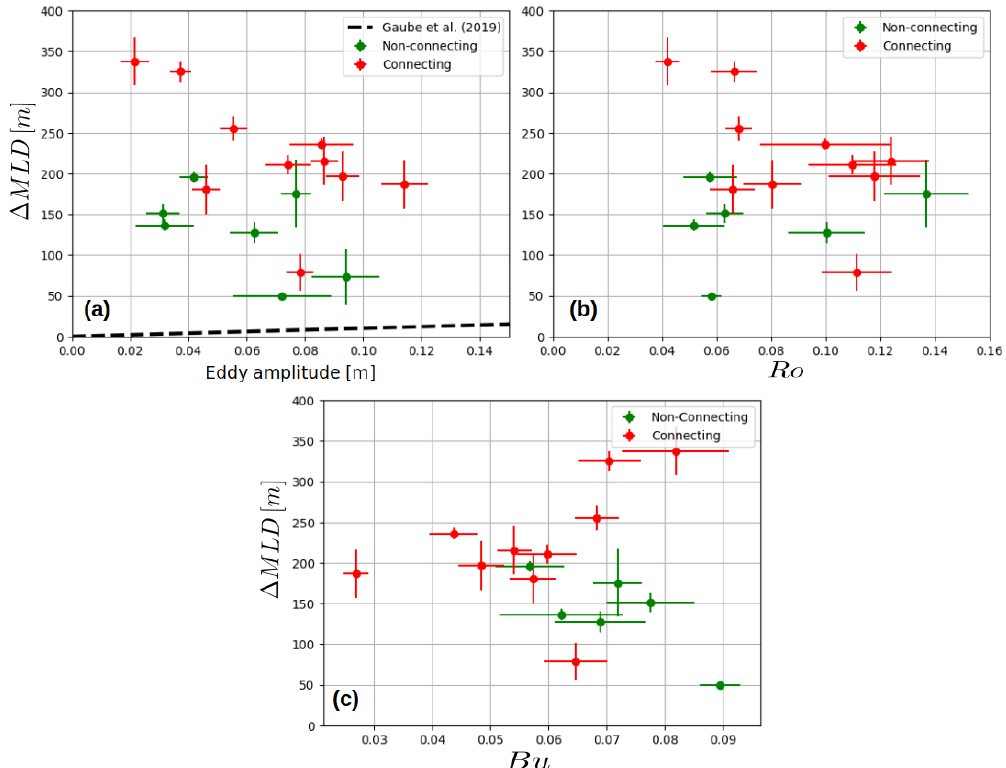
Figure 7. Relationship between maximal MLD anomaly ( (cid:49) MLD) and eddy parameters possibly measured through remote sensing: (a) eddy SSH amplitude, compared with proposed 1m MLD for 1cm SSH relation (Gaube et al., 2019); (b) Rossby number (eddy intensity); and (c) Burger number (non-dimensional eddy size).